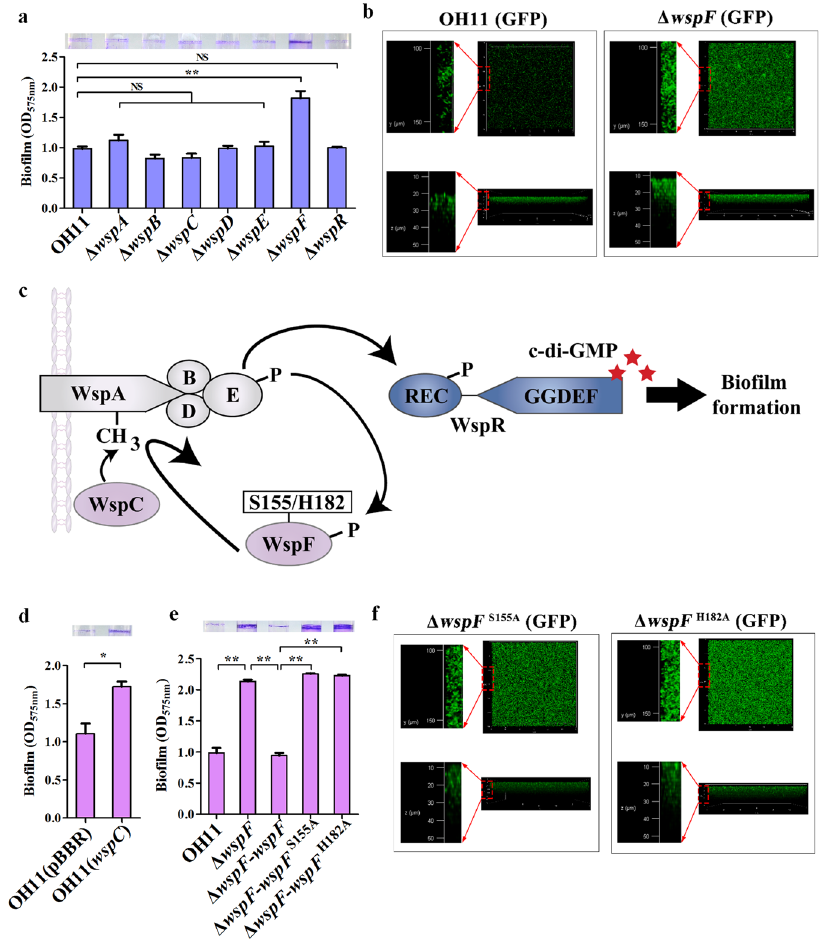
Fig. 1 Activation of the Wsp signaling system promotes bio fi lm formation in L. enzymogenes. a Effects of all Wsp signaling components on bio fi lm biomass through individual mutations in their respective encoding genes. Crystal violet (CV)-stained tubes were diluted with ethanol-acetone and OD 575 values measured to quantify bio fi lm biomass. On top, representative images of CV-stained bio fi lms were shown. b Confocal laser scanning microscopy (CLSM) of bio fi lms formed by wild-type and wspF mutant. CLSM was performed to observe the three- dimensional structure of bio fi lms. Images were acquired after 24 h using a 20× objective for green fl uorescent protein (GFP)-labelled cells grown on chamber-covered glass slides. The upper part of the black box represents the top surfaces of the three-dimensional bio fi lm structure (y and x axes), while the lower part of the black box shows the side surfaces of the three-dimensional bio fi lm structure (z and x axes). Red circles indicate image magni fi cation. c Schematic showing the Wsp signaling system for regulating c-di-GMP production in P . aeruginosa 16 . d Overexpression of wspC promoted bio fi lm biomass. e The enzymatic activity of WspF is crucial for regulating bio fi lm formation revealed by point mutations (S155A or H182A) of two predicated enzymatically active residues, S155 and H182. f Three-dimensional bio fi lm structures formed by L. enzymogenes carrying wspF variant ( wspF S155A or wspF H182A ) detected by CLSM. OH11, wild type; Δ wspA - Δ wspR , in- frame deletion mutant of each corresponding wsp gene; Δ wspF - wspF , Δ wspF - wspF S155A or Δ wspF - wspF H182A indicate native wspF , wspF S155A or wspF H182A was chromosomally inserted into the wspF mutant; OH11 (GFP) or Δ wspF (GFP) represents wild-type OH11 and Δ wspF carrying a plasmid-borne GFP; wspF S155A (GFP) and wspF H182A (GFP) represent Δ wspF - wspF S155A or Δ wspF - wspF H182A carrying a plasmid-borne GFP. Statistical comparisons were performed using one-way ANOVA of GraphPad software (GraphPad, La Jolla, CA). In panels a , d and e , mean data ± SD from three experiments were shown, * P < 0.05; ** P < 0.01. NS means not signi fi